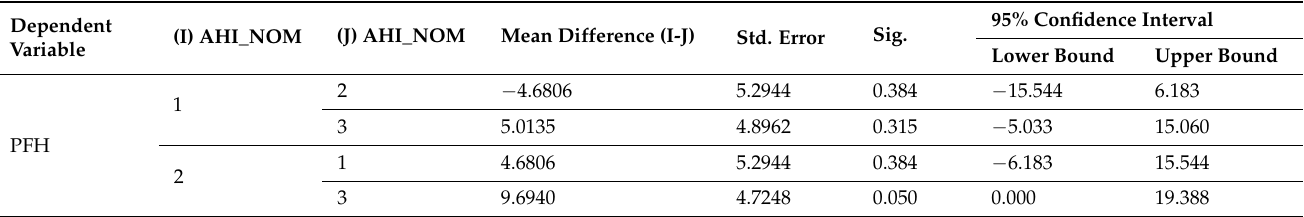
Table 4. LSD post-hoc analysis between posterior facial height (PFH) and OSA severity.